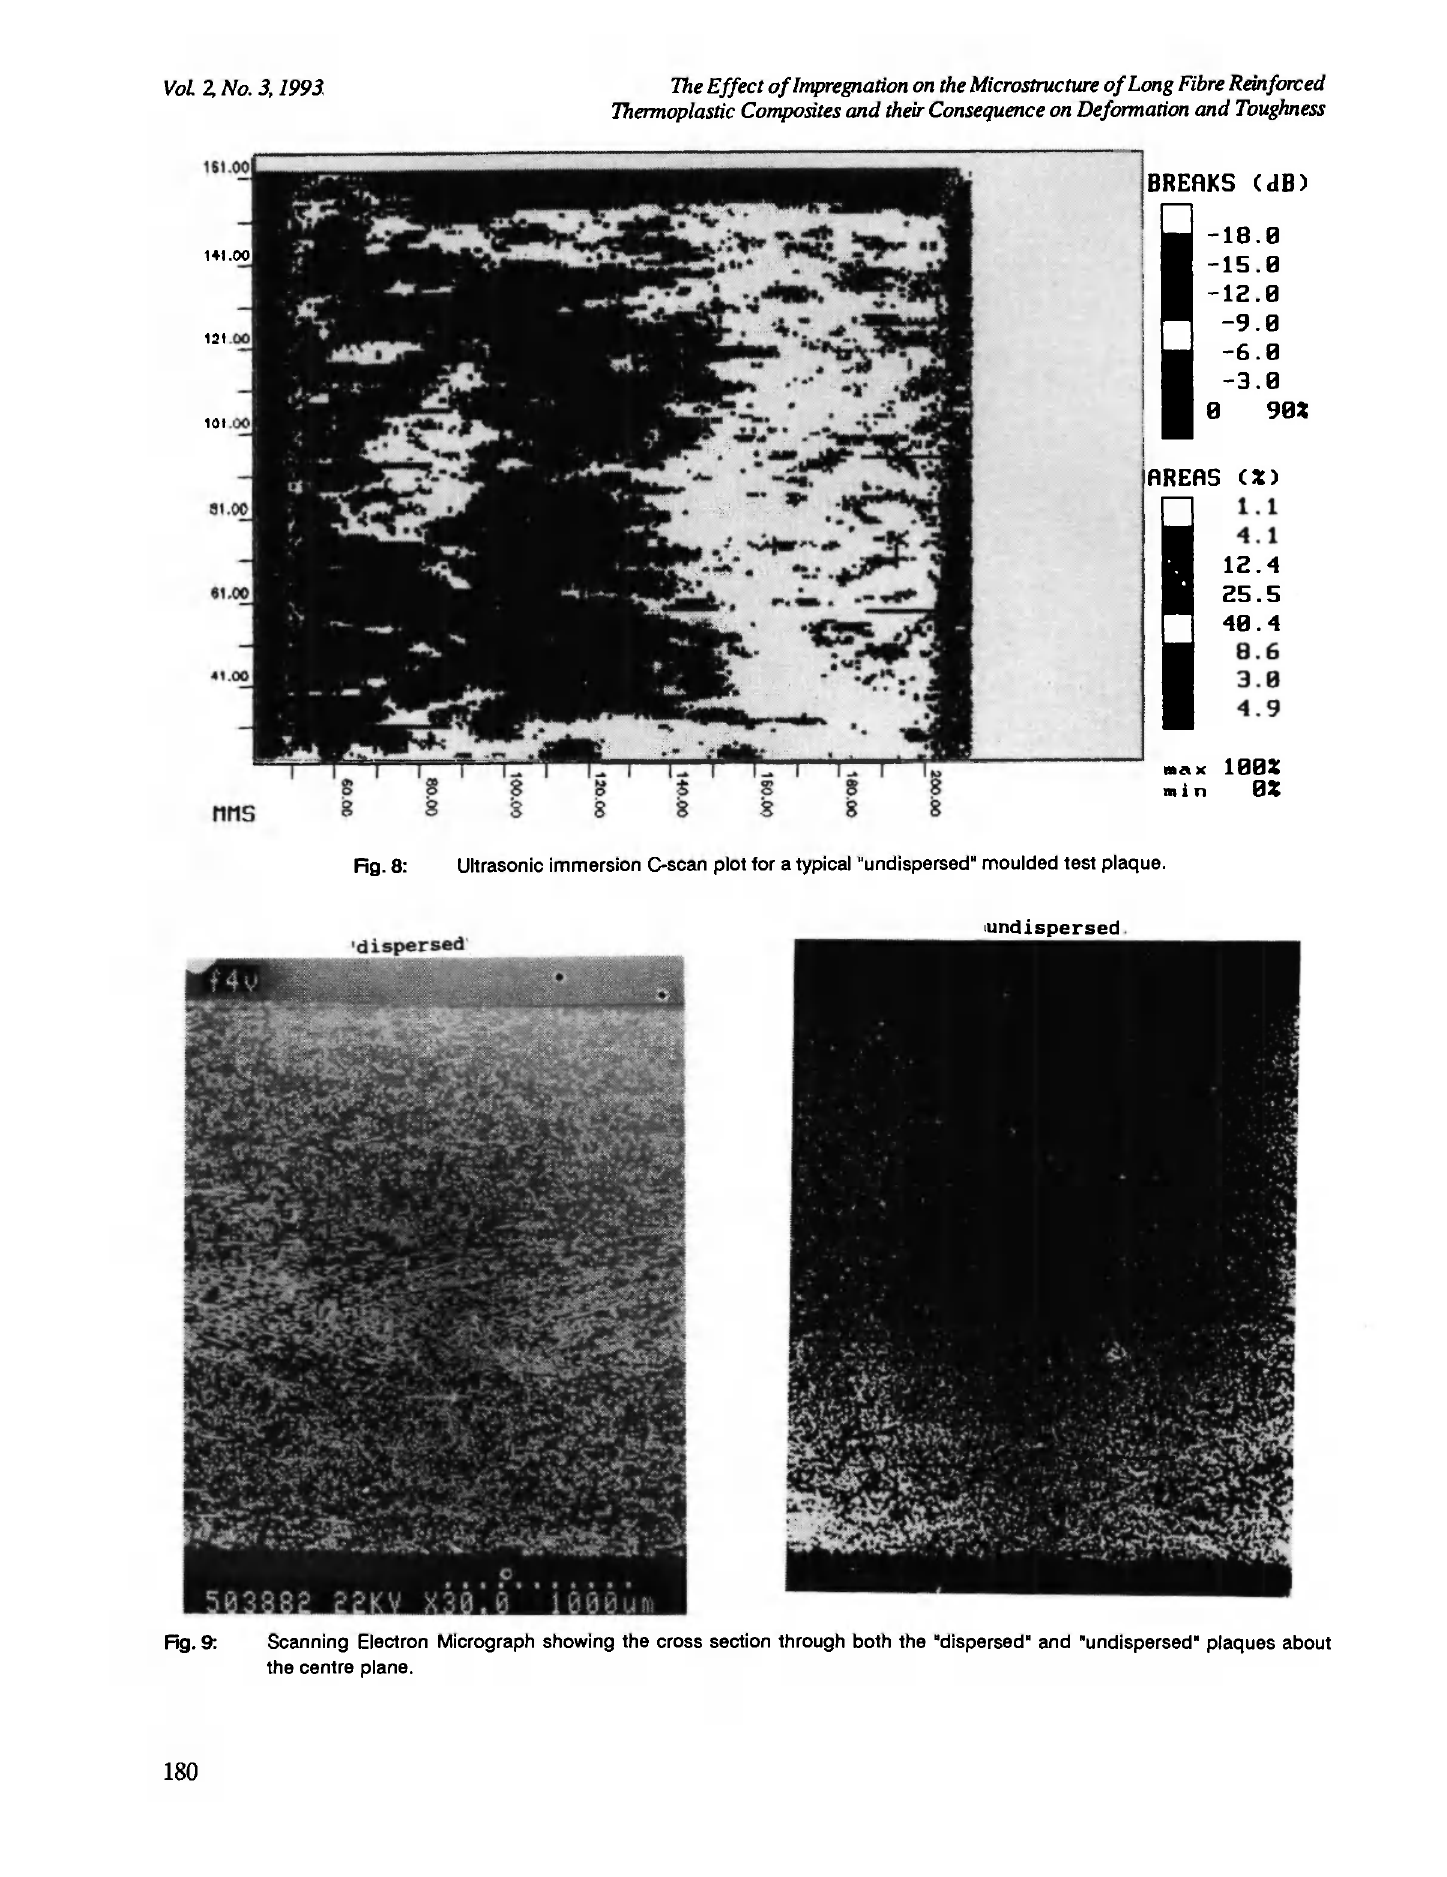
Fig. 8: Ultrasonic immersion C-scan plot for a typical "undispersed" moulded test plaque.